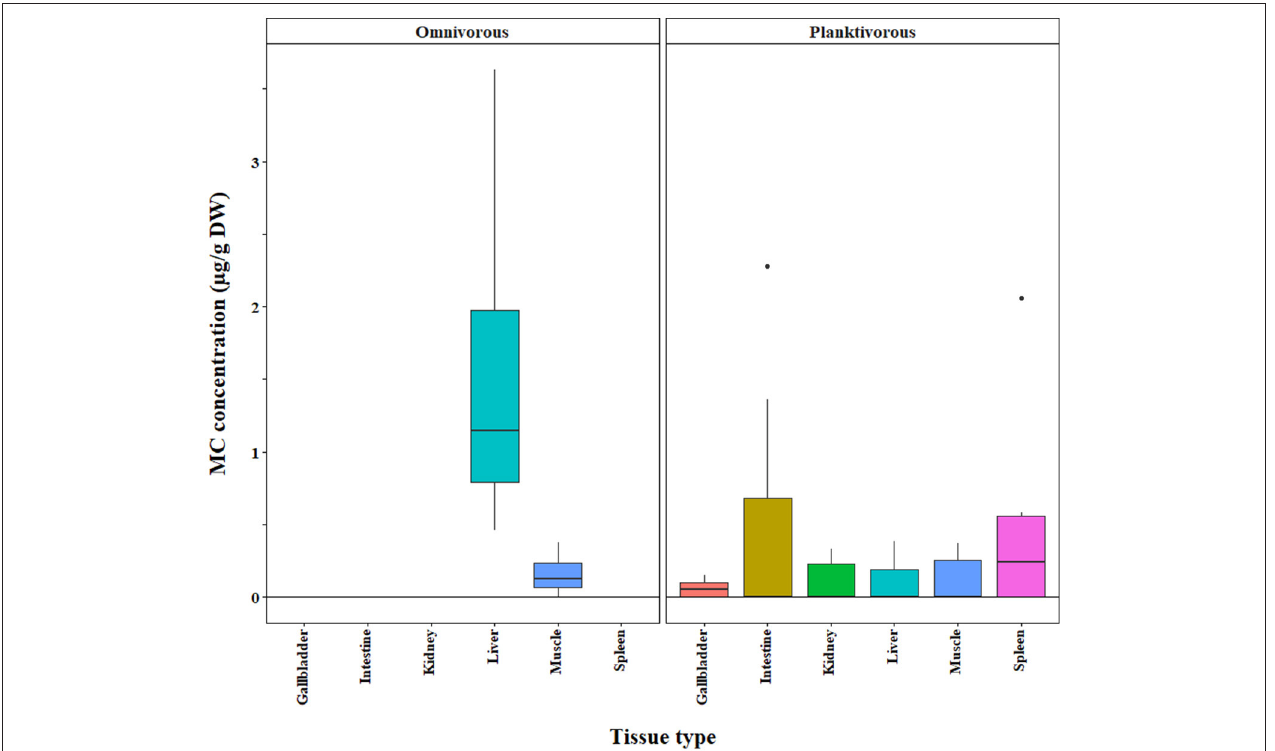
FIGURE 6 | Microcystin (MC) concentrations in the tissues of omnivorous and planktivorous fish tissues quantified by LC-MS. A subset of the original, raw data is shown for which significant differences between tissue types and feeding groups were detected in a bootstrap analysis of the residuals.